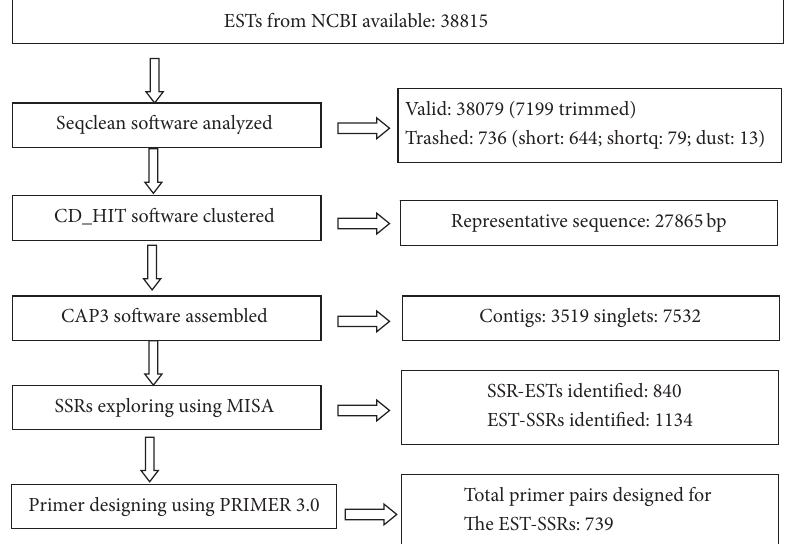
Figure 1: Scheme used for data exploring and development of EST-SSRs markers from Hevea brasiliensis ESTs.